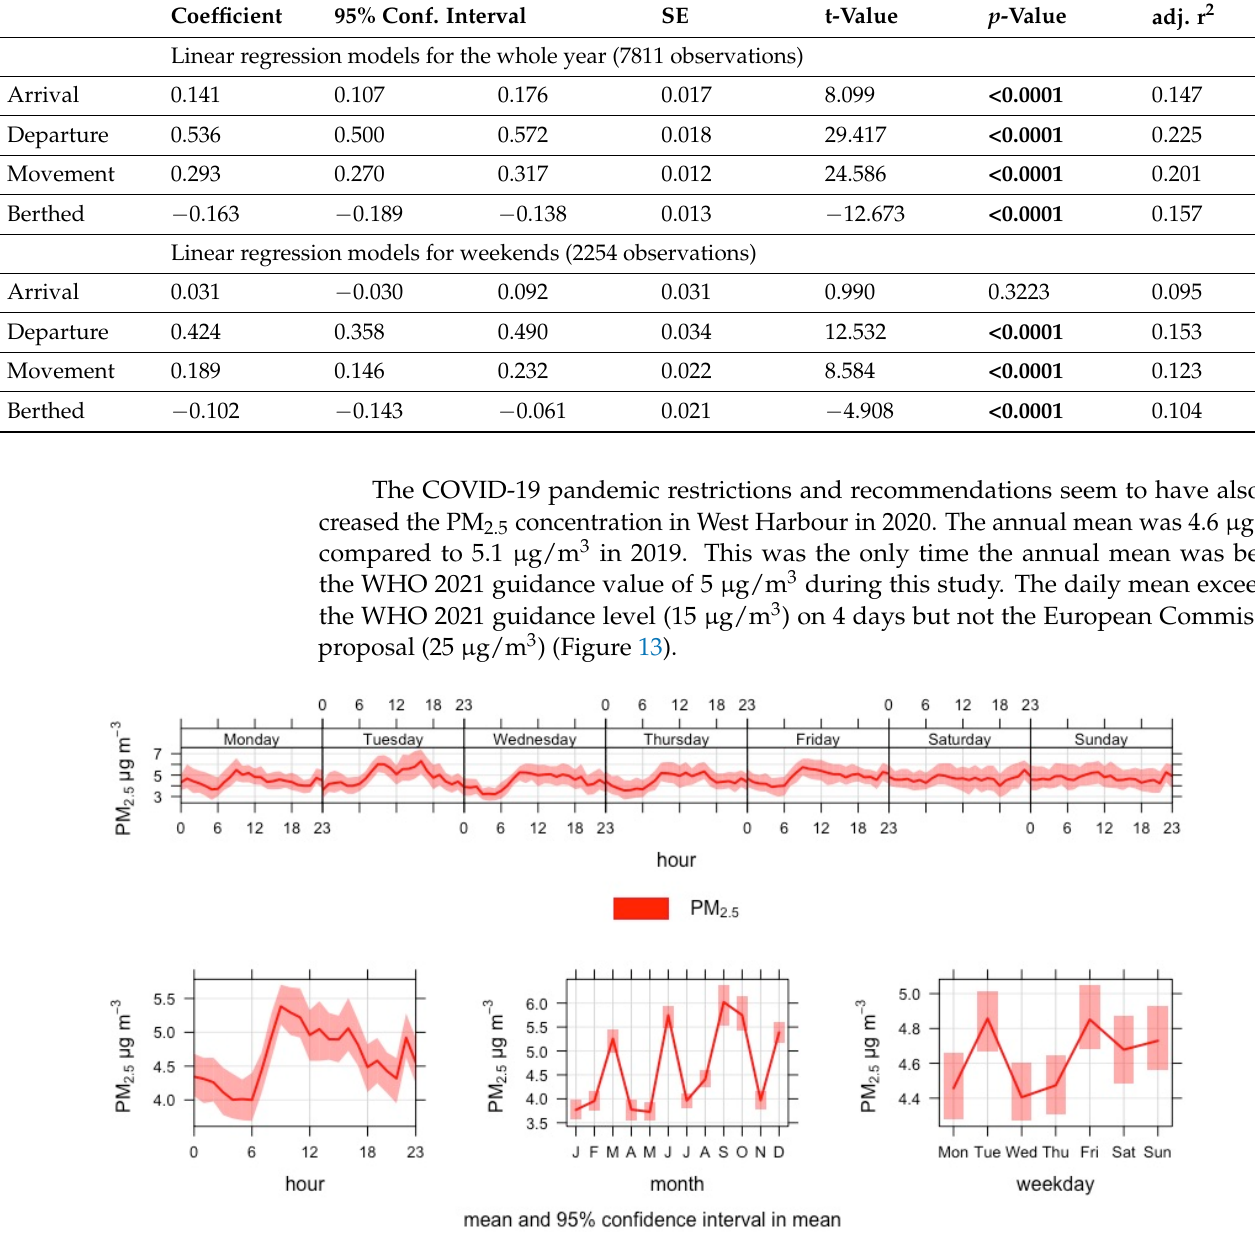
Figure 13. Time variation plot of PM2.5 concentration in West Harbour in 2020. The multivariable linear regression found a statistically signi fi cant association for de- parture, movement and vessels at berth and the natural logarithm of hourly mean PM 2 . 5 (Table 11) when controlled for wind speed, wind direction, air temperature, relative hu- midity and time of day. However, none of the vessel movement parameters were statisti- cally signi fi cant when analysed with the weekend-only data. Based on the analyses, the association between vessel movement and hourly mean PM 2 . 5 concentrations was weak or non-existent. Table 11. Multivariable linear regression analysis results for vessel arrivals, departures, movement and laying alongside to the logarithm of PM 2 . 5 hourly mean concentrations controlled for wind di- rection, relative humidity and air temperature at West Harbour in 2020. p -values less than 0.05 in bold. Coefficient